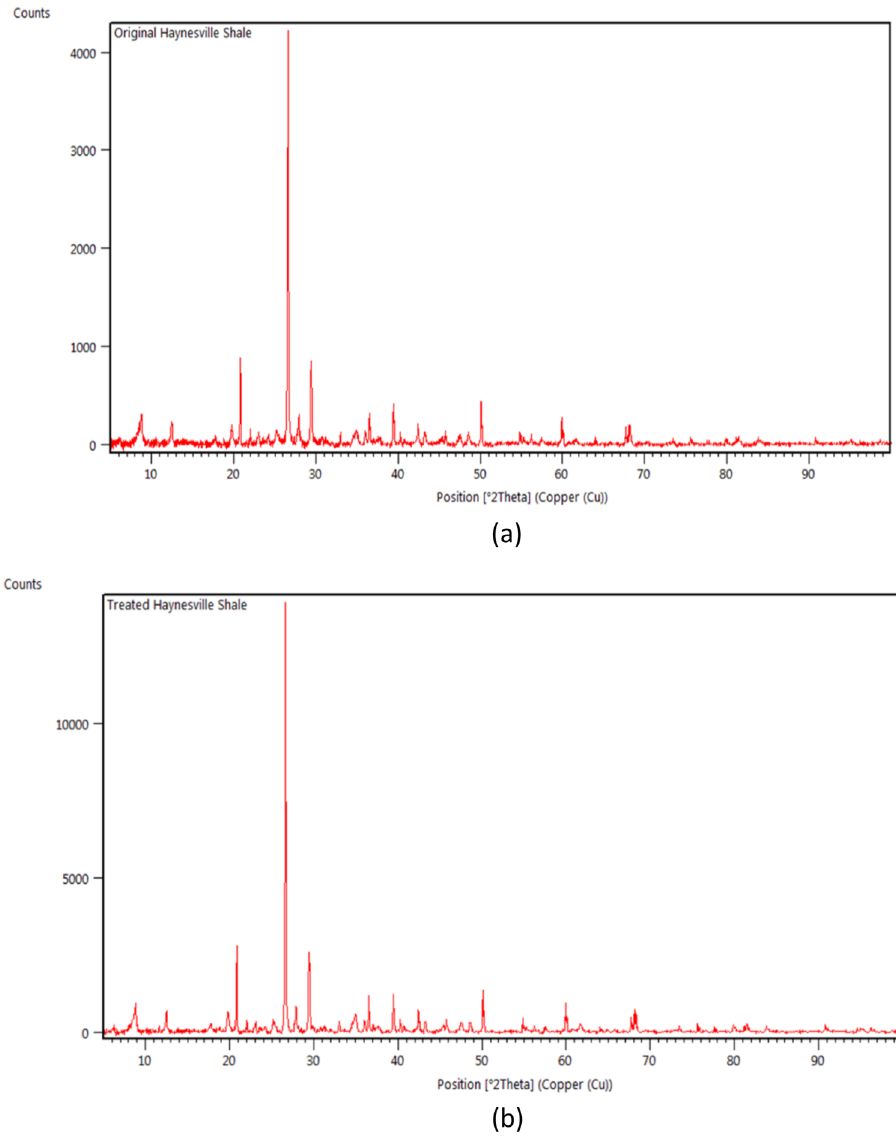
Figure 2. XRD patterns of Haynesville shale. ( a ) Original Haynesville Shale XRD. ( b ) Treated Haynesville Shale